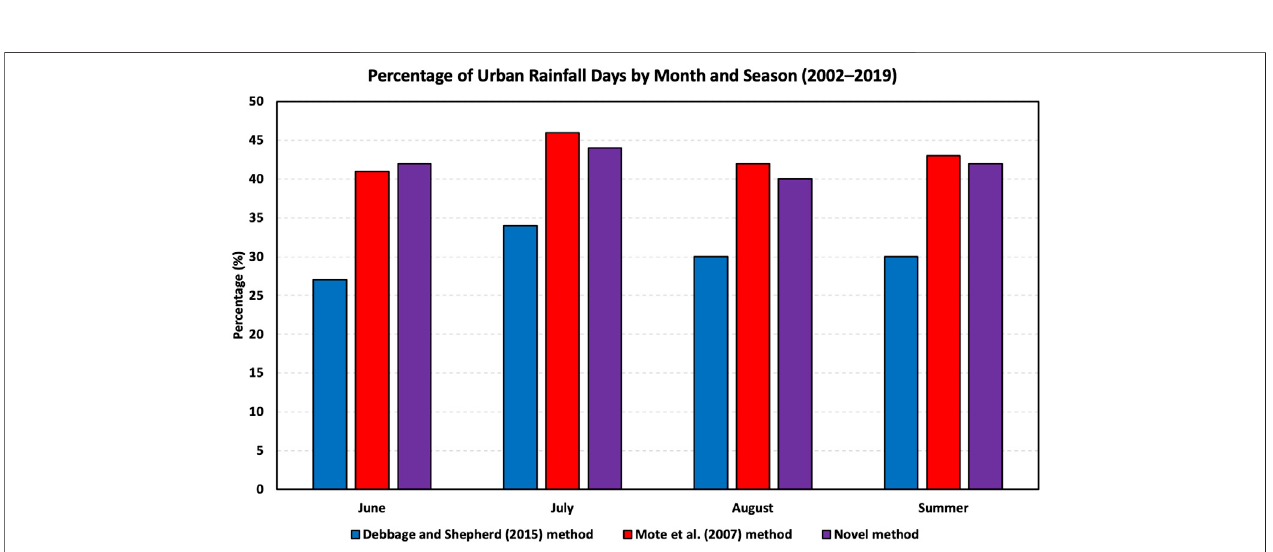
Frontiers in Environmental Science |